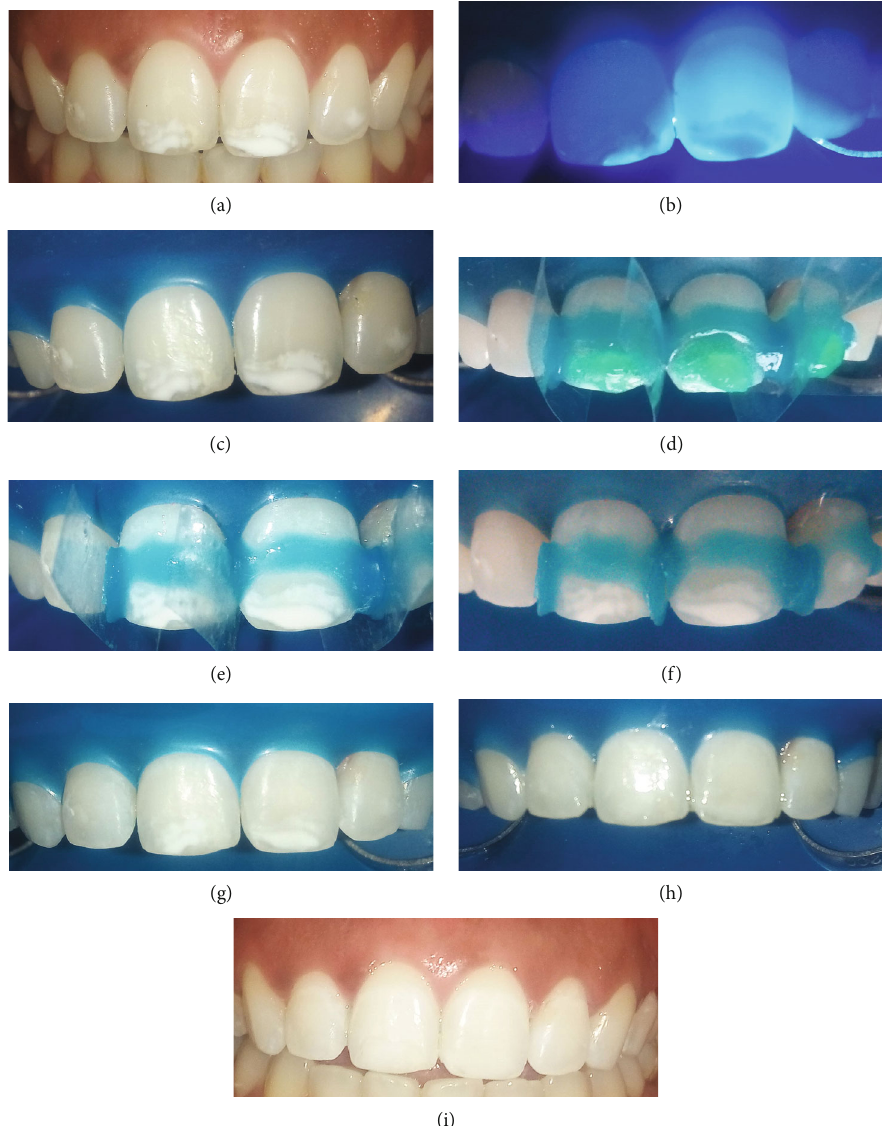
Figure 1: (a) White spot lesion related to molar-incisor hypomineralization. (b) Evaluation of the depth of the lesion under transillumination. (c) Isolation with a rubber dam. (d) Application of the acid gel (120s) and washing with water spray. (e) Application of an ethanol drier. (f) The appearance of enamel surfaces after ethanol application. (g) Second application of an ethanol drier. (h) Application of a low-viscosity resin in fi ltration and polymerization. (i) Immediately fi nal